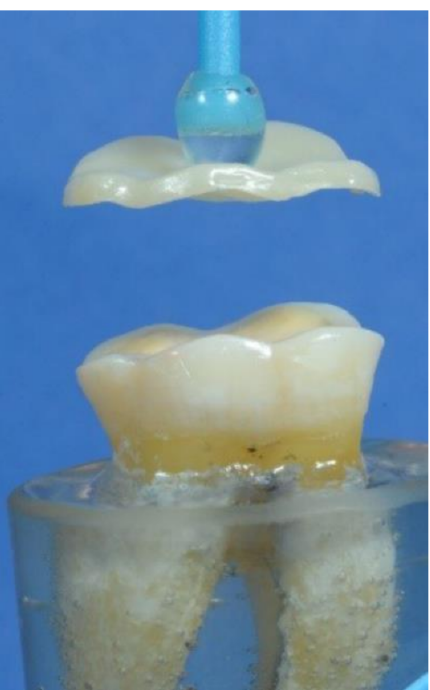
Figure 2. The occlusal veneer during cementation to its corresponding